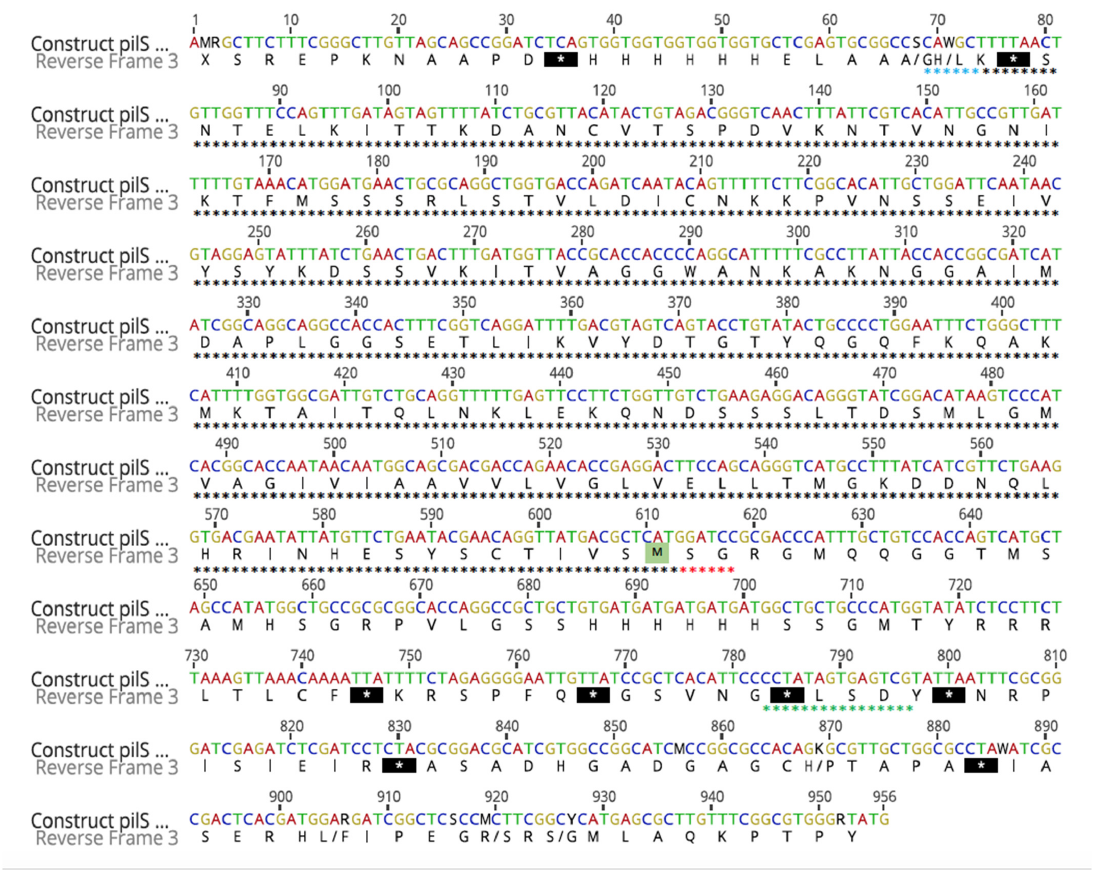
Figure 2. Sequencing of pilS constructs in expression vector pET28a. Geneious plus software was applied to analyze and identify the sequences in the construct. The pilS sequence is marked with a black asterisk; BamHI and HindIII enzymes sequence are highlighted with red and blue asterisks, respectively; T7 promoter is indicated with green asterisks. In the pilS sequence the start codon is highlighted with a green square and the stop codon with a black square.